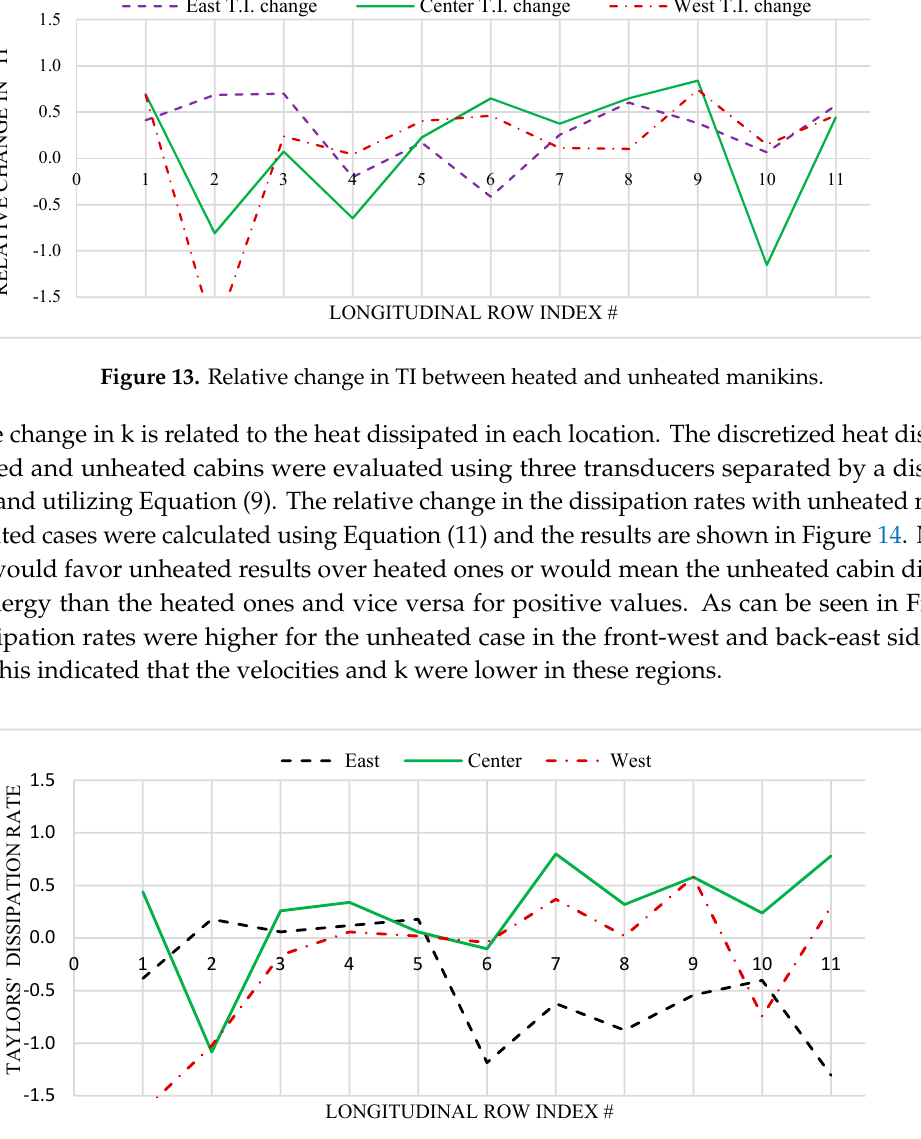
Figure 14. Dissipation rate relative change between heated and unheated cases.